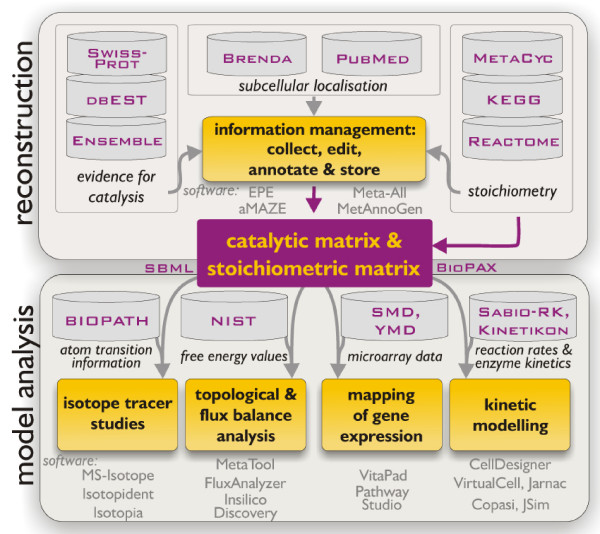
Intercorrelation of METANNOGEN with knowledge-bases and network modelling tools. The user manually collects information from biochemical reactions. The network is exported as a SBML file and may be processed with network modelling/analyzing tools.